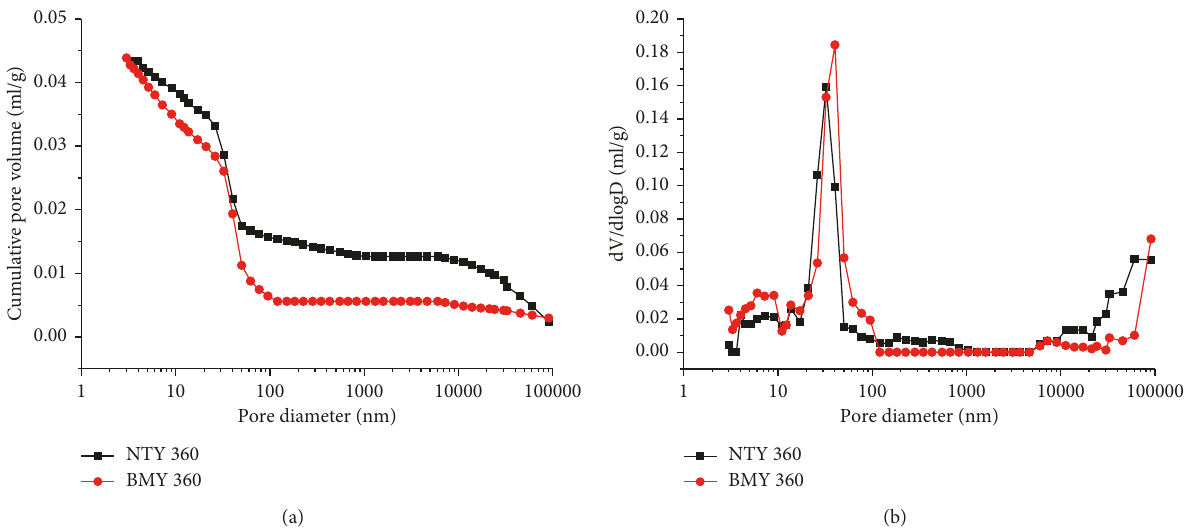
Figure 7: Pore distribution of concrete with and without CPF liner. (a) Integral curves. (b) Differential curves.